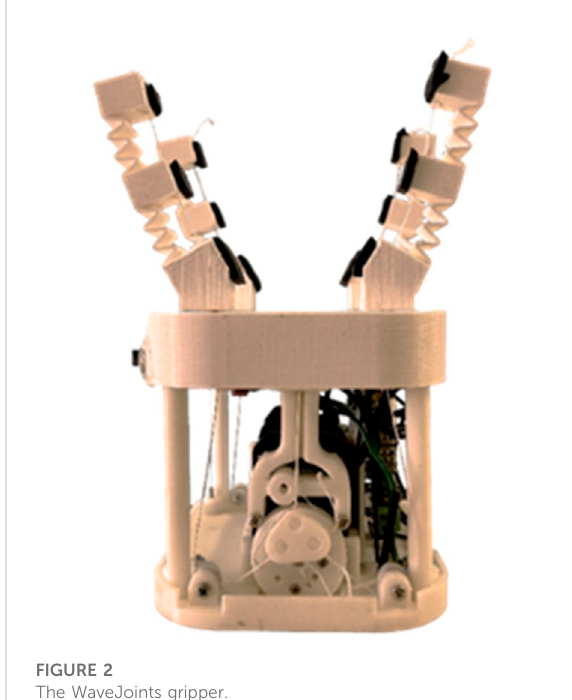
FIGURE 2 The WaveJoints gripper.